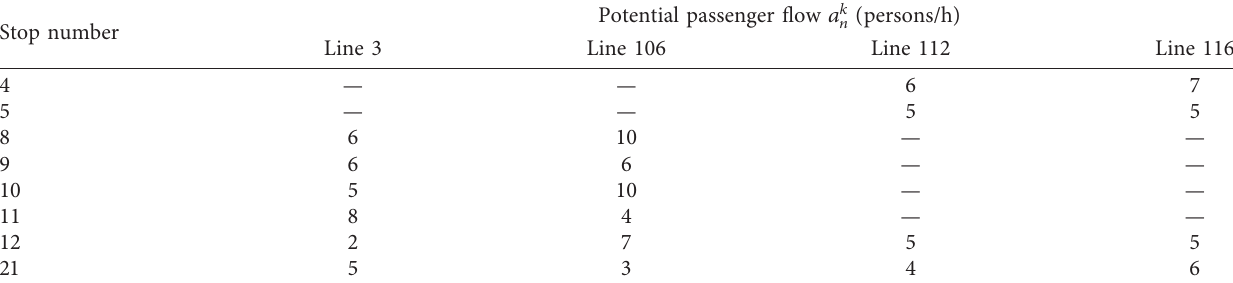
Table 5: The number of passengers attracted by the stop.